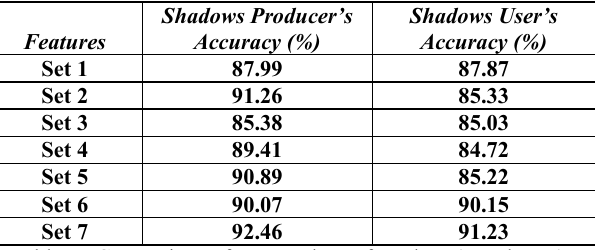
Table 7. Comparison of mean values of producer’s and user’s accuracies for “shadows” class and the seven sets of features.